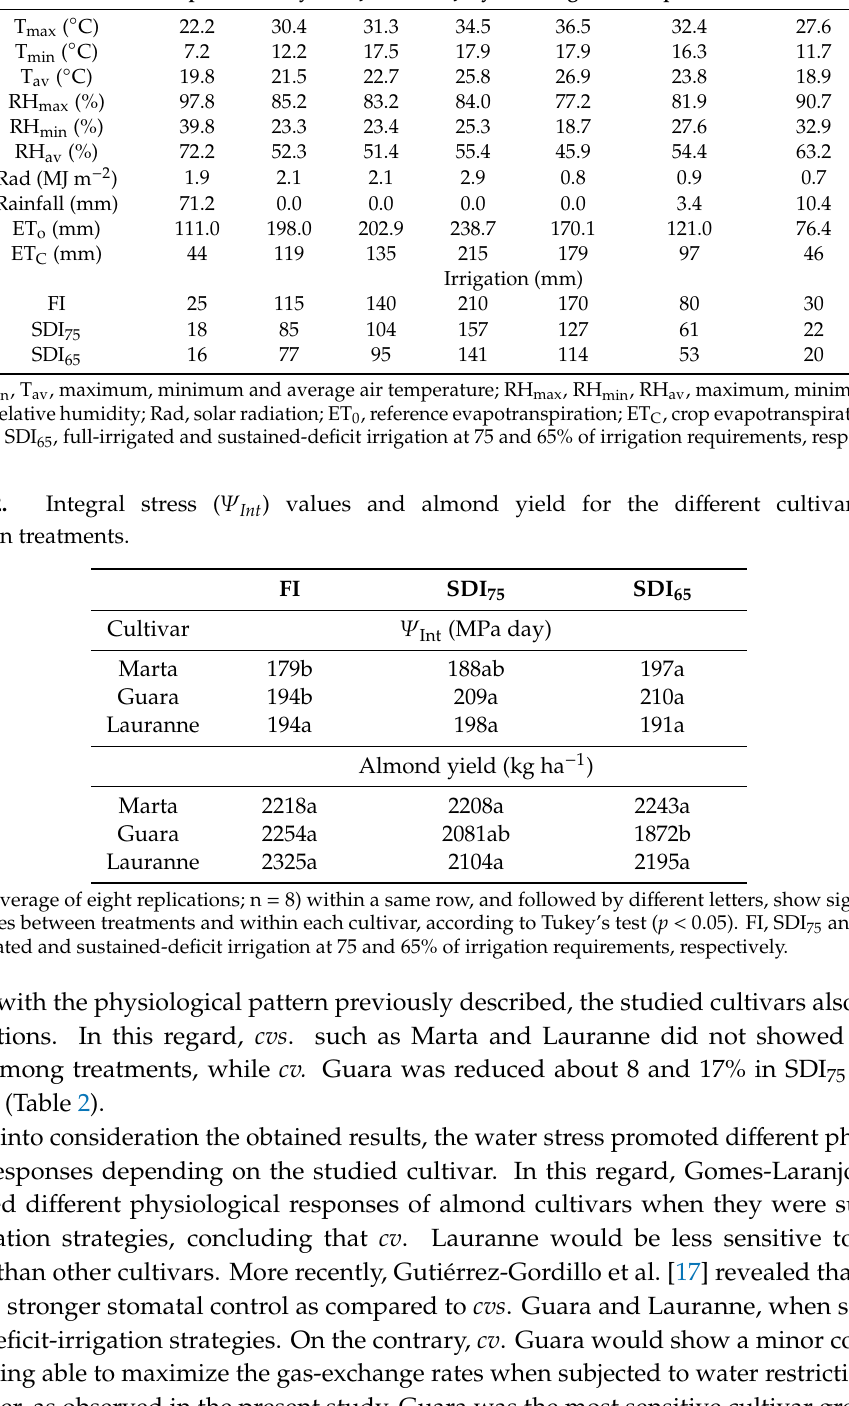
Table 1. Monthly average values of weather parameters and irrigation doses during the study period. Parameters